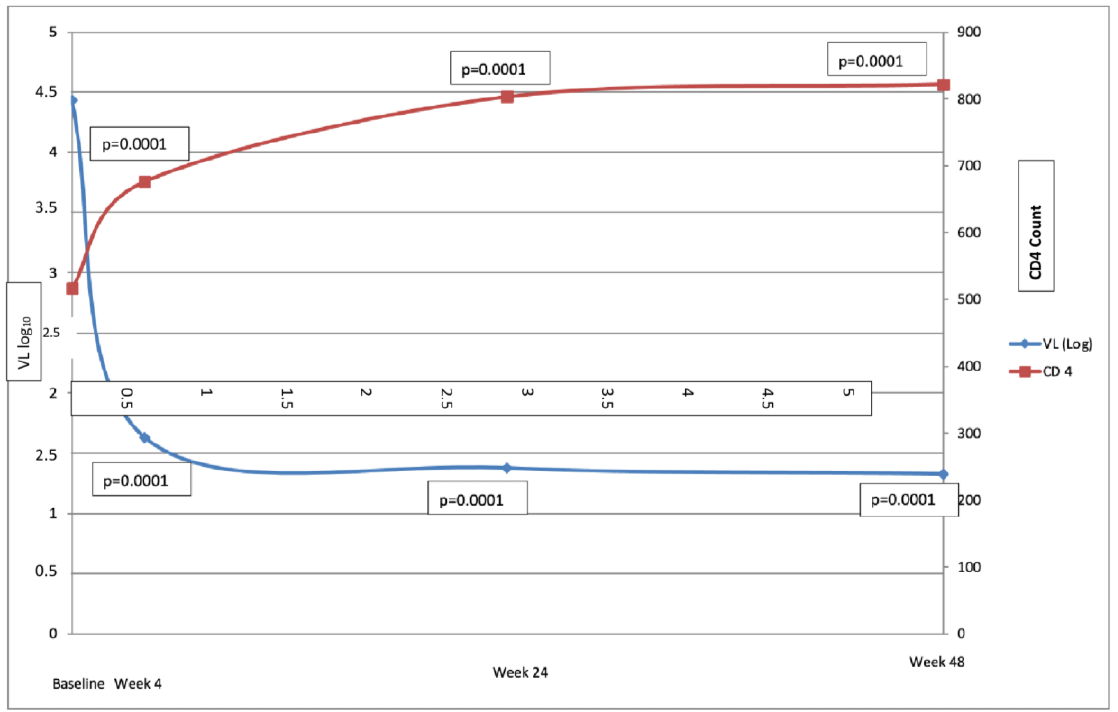
Figure 2. Time course of CD4 and viral load (baseline and weeks 4, 24, and 48 weeks).